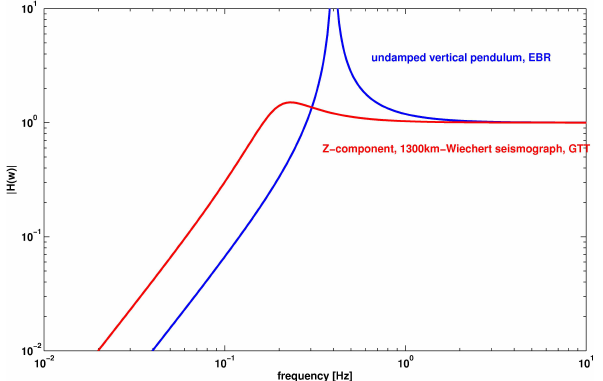
Figure 8. Frequency-dependent normalized transfer functions of a nearly optimally damped (station GTT, red) and an undamped (station EBR, blue) mechanical seismometer. The transfer function of the Z component of the 1300kg Wiechert seismograph shows a constant plateau for frequencies greater than 0.2Hz. In contrast, a resonance from 0.18 to 1.26Hz of the undamped vertical pendu- lum disturbs the recordings